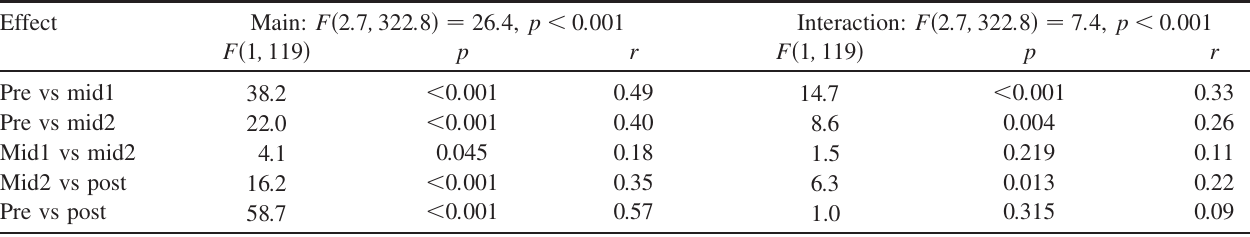
TABLE IV. Repeated measure analysis of variance: work-energy subscore.